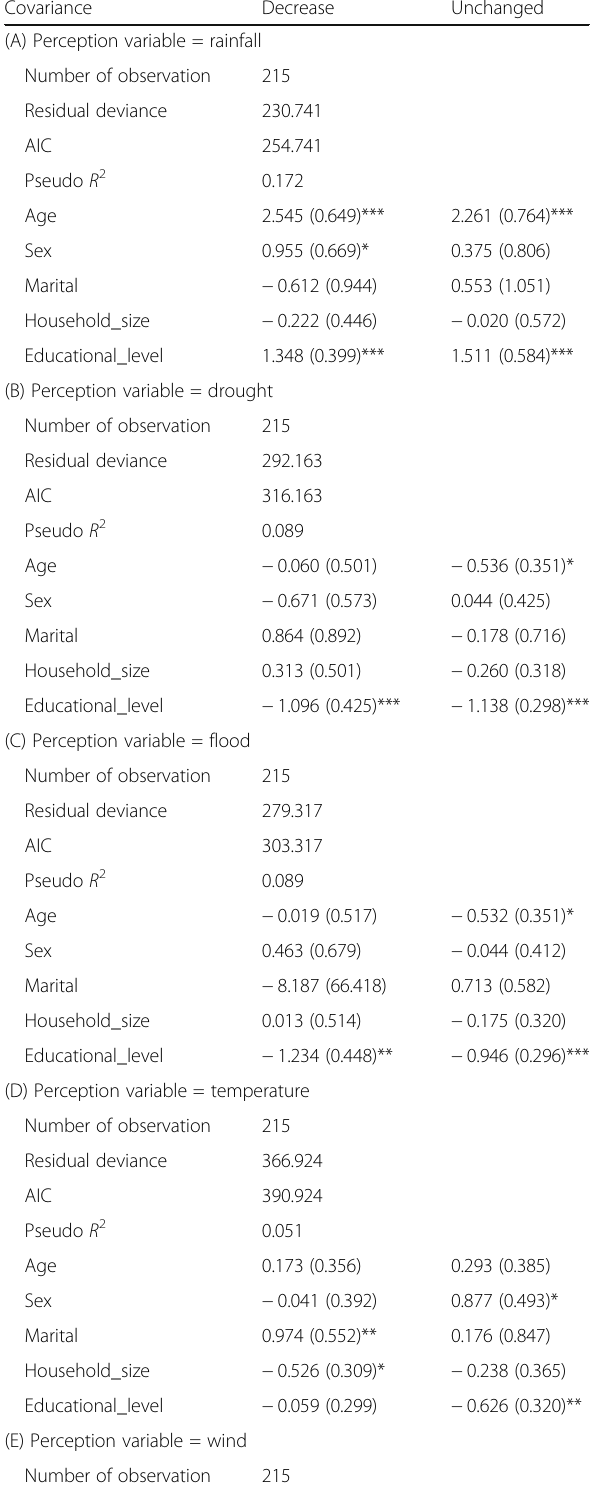
Table 3 Results of multinomial regression of G. kola farmer ’ s perceptions of climate change according to some explanatory variables